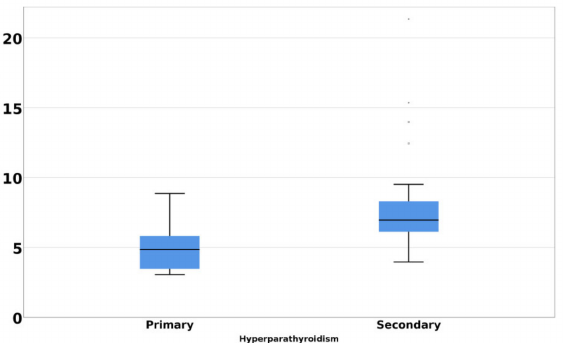
Figure 3. Mean SWE elastography values in primary hyperparathyroidism versus secondary hyper-